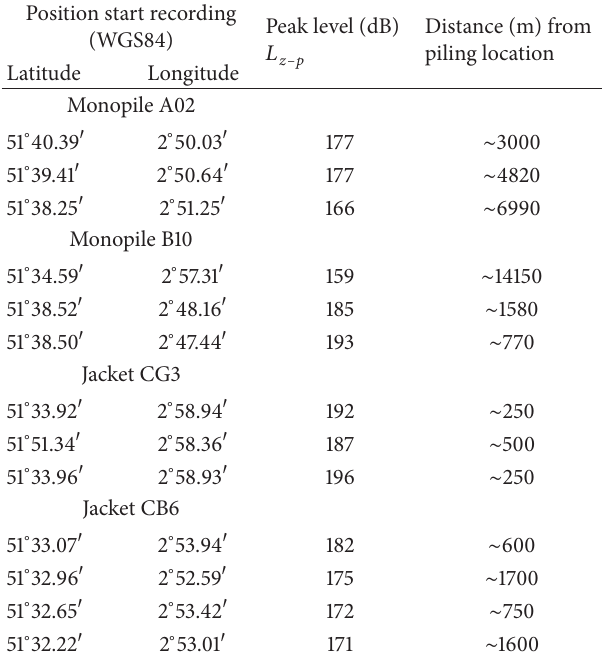
Table 1: Geographic position, peak level ( 𝐿 𝑧 the piling location of the underwater noise measurements at the Blighbank site (monopiles A02 and B10) and at the Thorntonbank site (jackets CG3 and